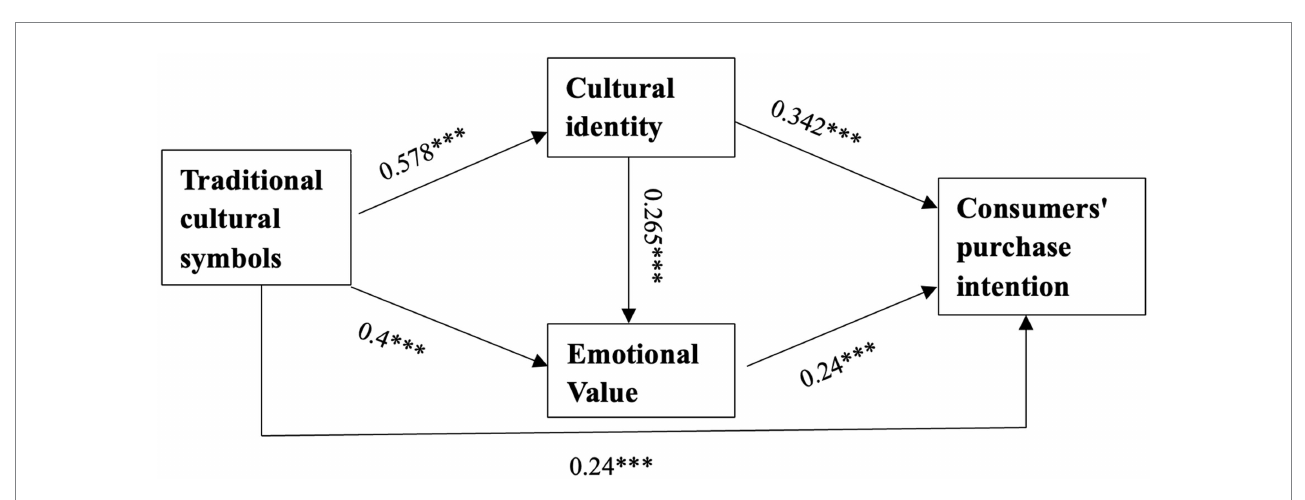
lies not only in their superior quality but also in the spirit of Japanese craftsmanship.